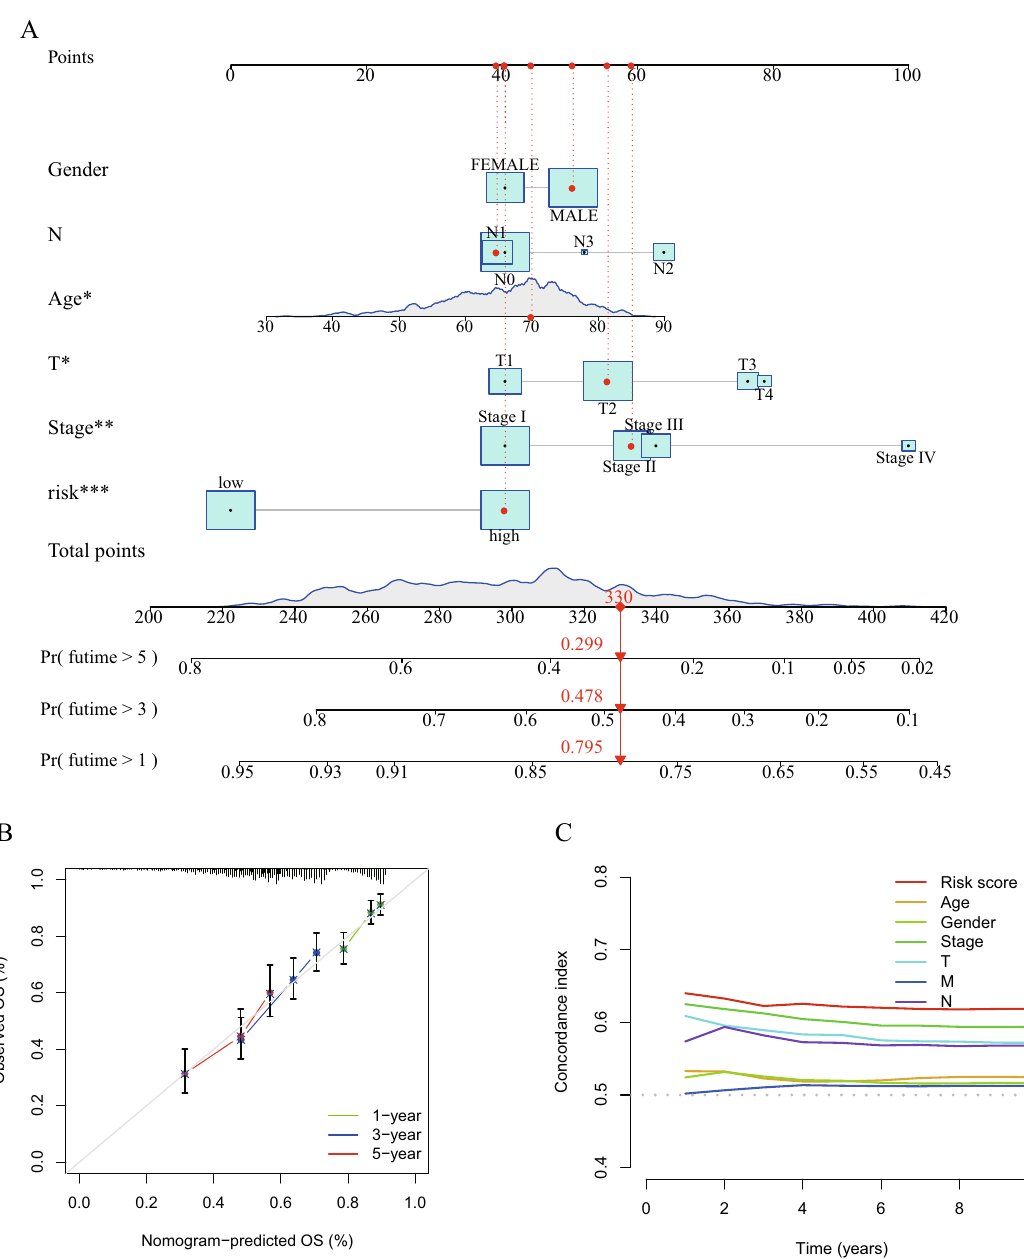
Figure 5. ( A ) A nomogram to predict 1-, 3- and 5-year OS of patients with lung cancer. ( B ) Nomogram- based calibration curves that show consistency between predicted and detected 1-, 3- and 5-year survival. ( C ) The c-index curve to compare the predictive ability of the risk score and the other clinical factors. OS, overall